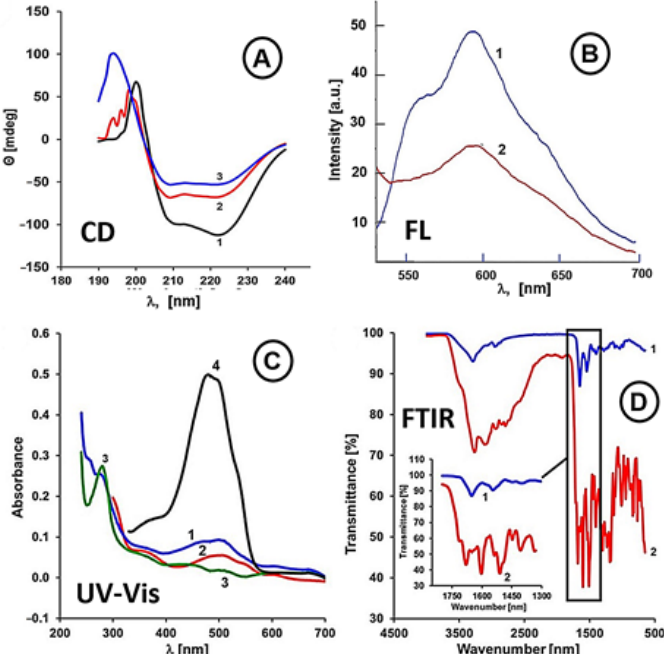
Figure 3. ( A ) Circular dichroism spectra for a 1 mg/mL solution of a wild-type APO with and without an encapsulated drug: (1) bare APO; (2) APO(IDA) nanocarrier; and (3) APO(DOX) nanocarrier. Spectra were recorded in water at 25 ◦ C in a 0.5 cm quartz cuvette. ( B ) Fluorescence emission spectra ( λ ex = 480 nm) for nanocarriers: APO(DOX) (blue line, 1 ), APO(DOX)@FA (red line, 2 ). ( C ) UV-Vis spectra for: APO(DOX) (blue line, 1 ), APO(DOX)@FA (red line, 2 ), APO (green line, 3 ), and DOX (black line, 4 ). ( D ) FTIR spectra of APO(DOX) (blue line, 1 ) and APO(DOX)@FA (red line, 2 ) nanocages.2.3. Attachment of Folate Targeting Ligands to APO Nanocages.